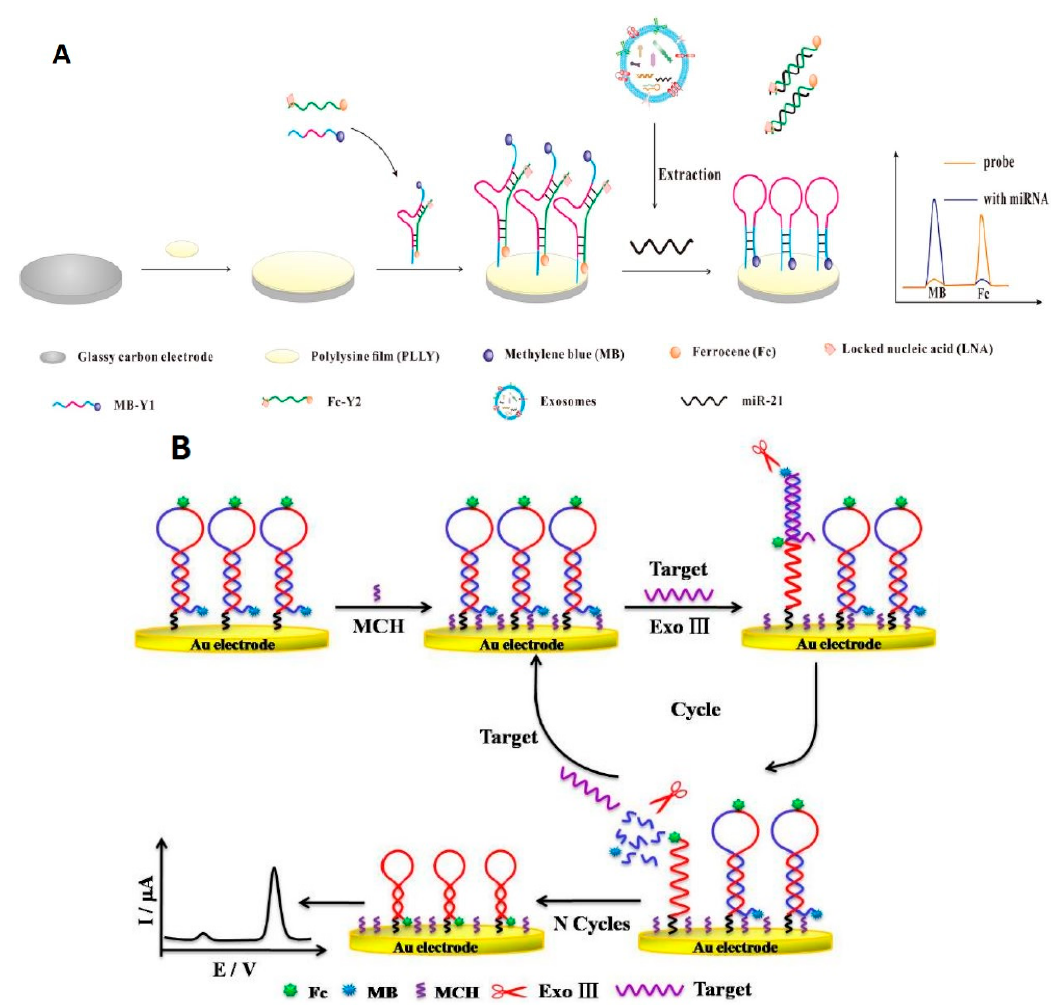
Figure 4. Example of biosensor obtained with two DNA label with two RedOx markers; ( A ) standard design reproduced from [68] with permission of publisher, ( B ) same approach using amplification strategy reproduced with permission of the publisher from [63].